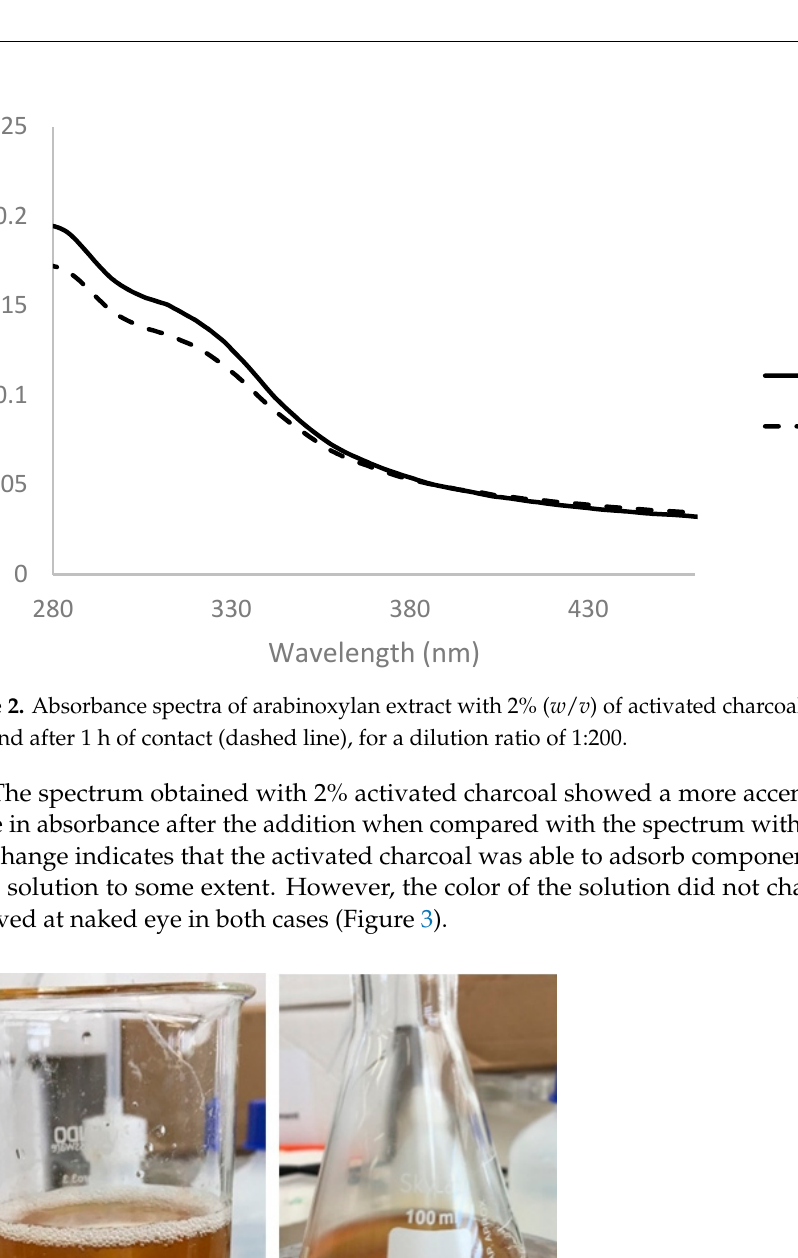
Figure 1. Absorbance spectra of arabinoxylan extract with 0.5% ( w / v ) of activated charcoal before (full line) and after 1 h of contact (dashed line), for a dilution ratio of 1:200.